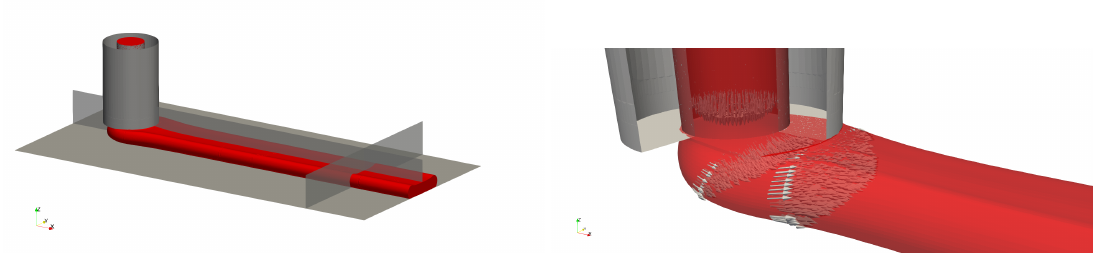
Figure 9. Example of strand shape for h / d = 0.5 and V / U = 1 with the transversal and longitudinal cutting planes. Close-up of the velocity distributions near the nozzle